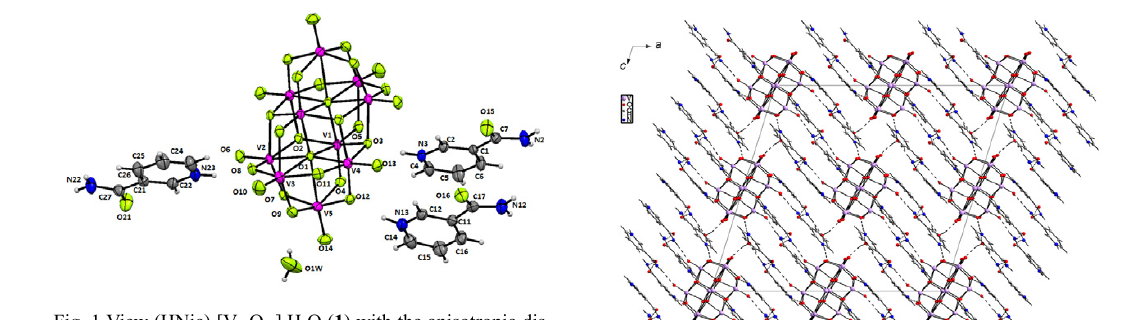
Fig. 1 View (HNic) [V O ].H O ( 1 ) with the anisotropic dis- 6 10 28 2 placement parameters. The labelling scheme of the atoms is shown only in the asymmetric unit. Fig. 2 Supramolecular architecture of compound 1 along